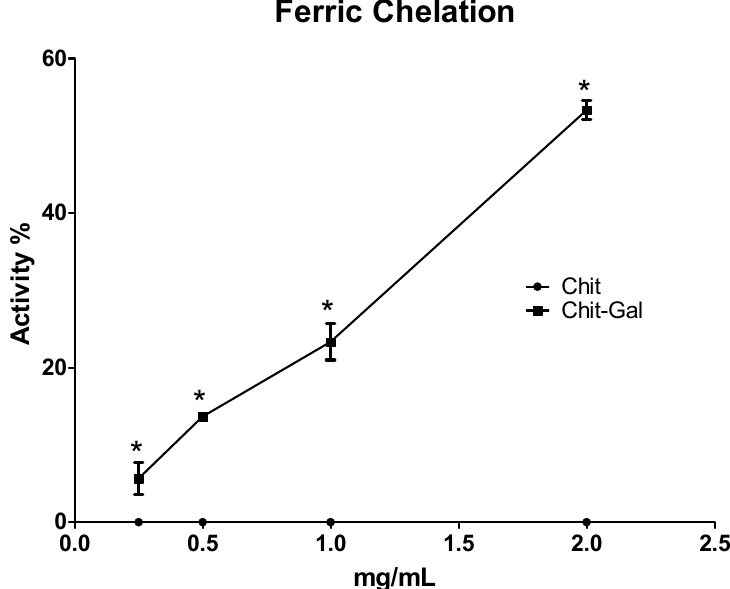
Figure 7. Iron chelating activity. The * indicates statistical difference ( p < 0.05). EDTA was used as a positive control and had 100% activity at a concentration of 0.025 mg/mL.